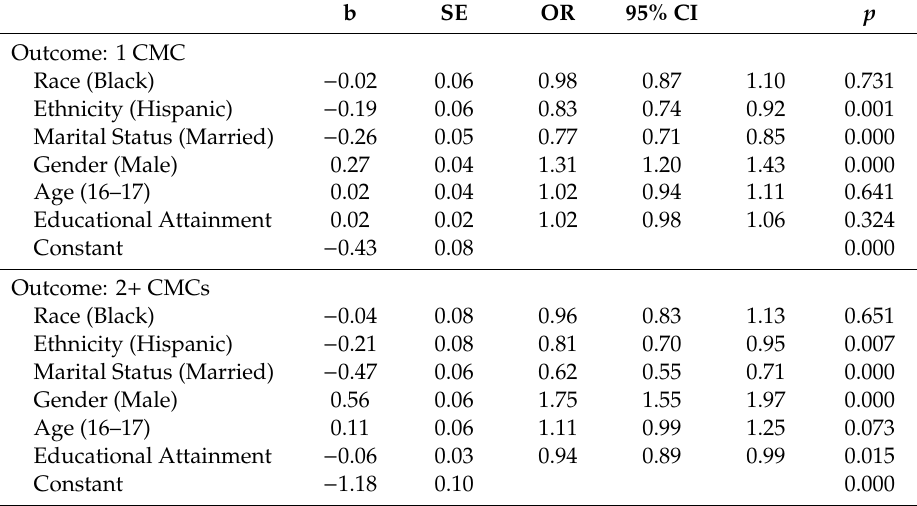
Table 4. Summary of multinomial regression (Model 3) with only main e ff ects on the number of Chronic Medical Conditions (CMCs) in the pooled sample.